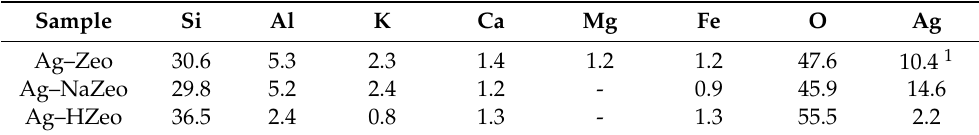
Table 1. Element composition (in wt.%) for all samples based on EDX